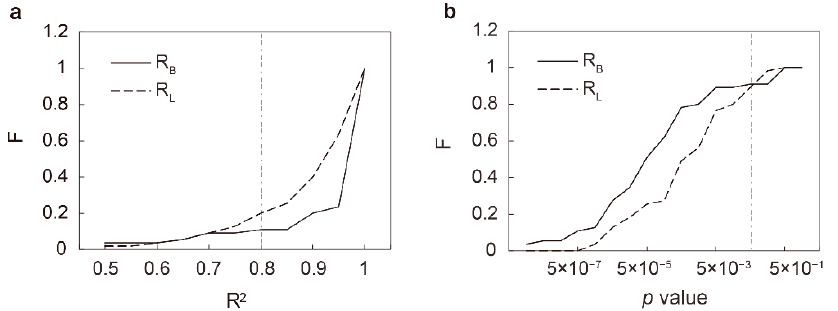
Figure 3. Distributions of river network parameters for endorheic sub-basins considered. Empirical cumulative distribution function of ( a ) the coefficients of determination, R 2 , and ( b ) the p value obtained during self-similarity test. F in ( a , b ) refers to the frequency of sub-basins whose R 2 or p do not exceeding a certain value.